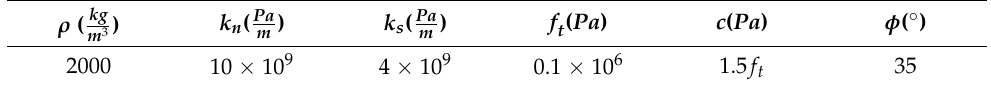
Figure 6. Historical building ( left ) and computational model ( right ); Dimensions: H 1 : 2.85, H 2 : 1.9, H 3 : 10, L 0 : 8, L 1 : 1.15—Dimensions are in meters, and columns are denoted as C i = 1:5 . Table 1. Material and contact properties.